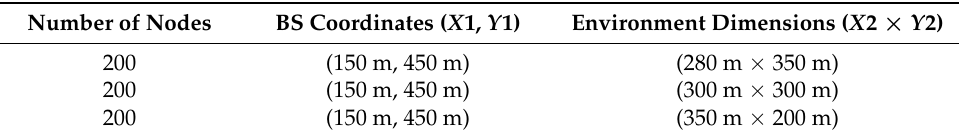
Table 2. The essential simulation parameters of the first